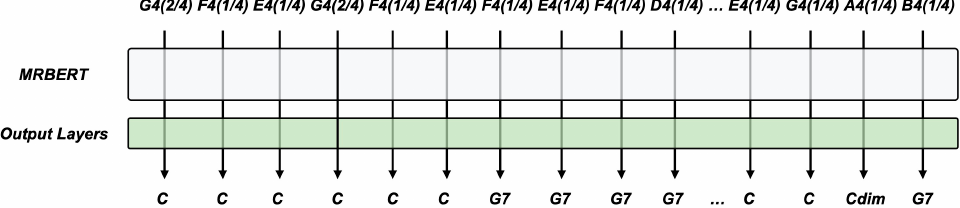
Figure 5. Pipeline of Seq2Seq generation. Melody and rhythm can be of any length, and the length of the generated chords vary accordingly.